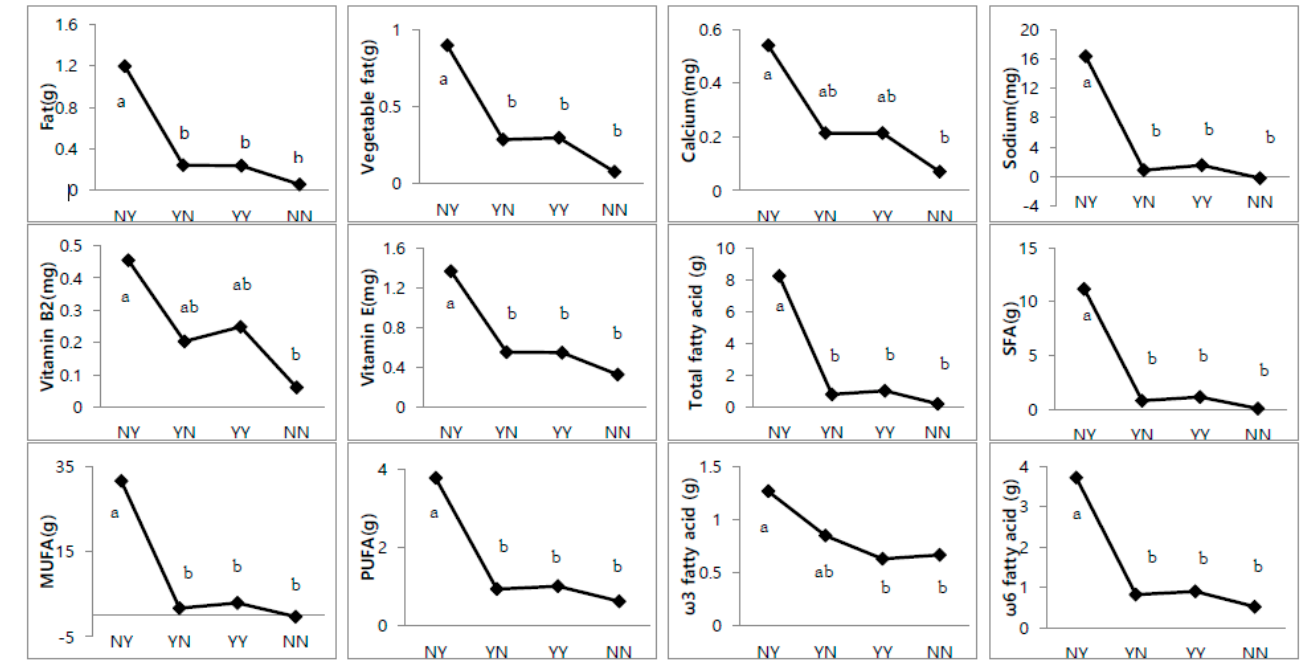
compared to the other groups.